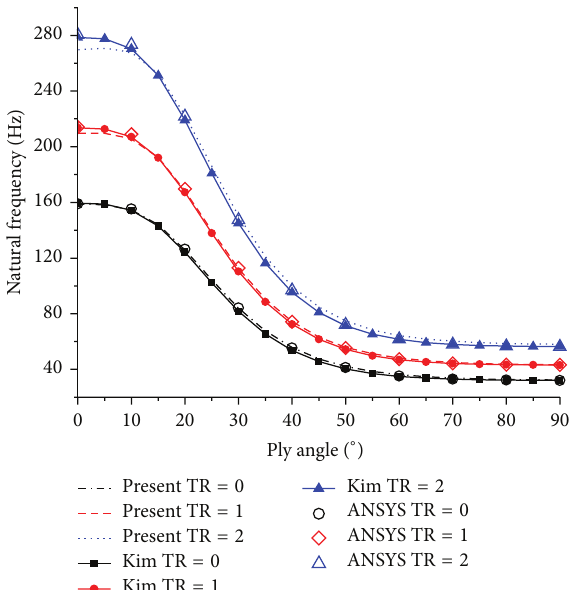
Figure 5: The first natural frequency versus ply angle ( Ω = 0 rad/s).